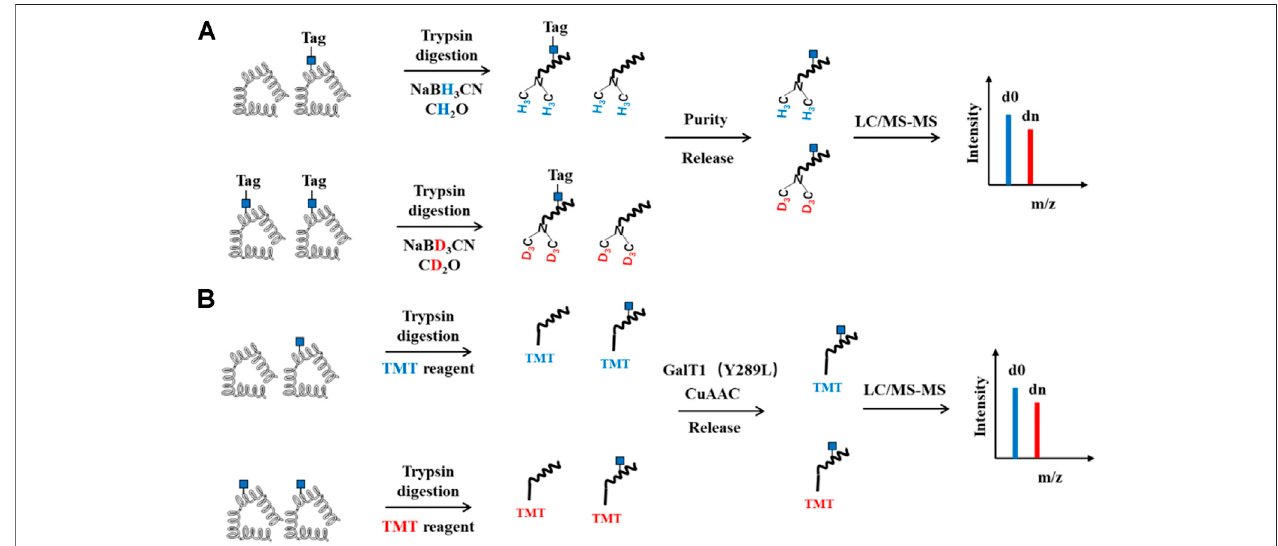
FIGURE 6 | Schematic of QUIC and TMT Quantitative strategy for O-GlcNAcylation. (A) QUIC-Tag strategy. O-GlcNAcylated proteins fi rst are chemoenzymatic labeled with a tag containing cleavable group and biotin, followed by trypsin digestion. The peptides are labeled with NaCNBH3 or NaCNBD3 by a modi fi ed dimethyl labeling strategy. Subsequently, O-GlcNAcylated peptides are enriched by streptavidin agarose and then released, mixed and analyzed by LC-MS/MS. (B) TMT strategy. The proteins are digested, labeled with TMT. O-GlcNAcylated peptides are then enriched, released and subjected to LC-MS/MS analysis.